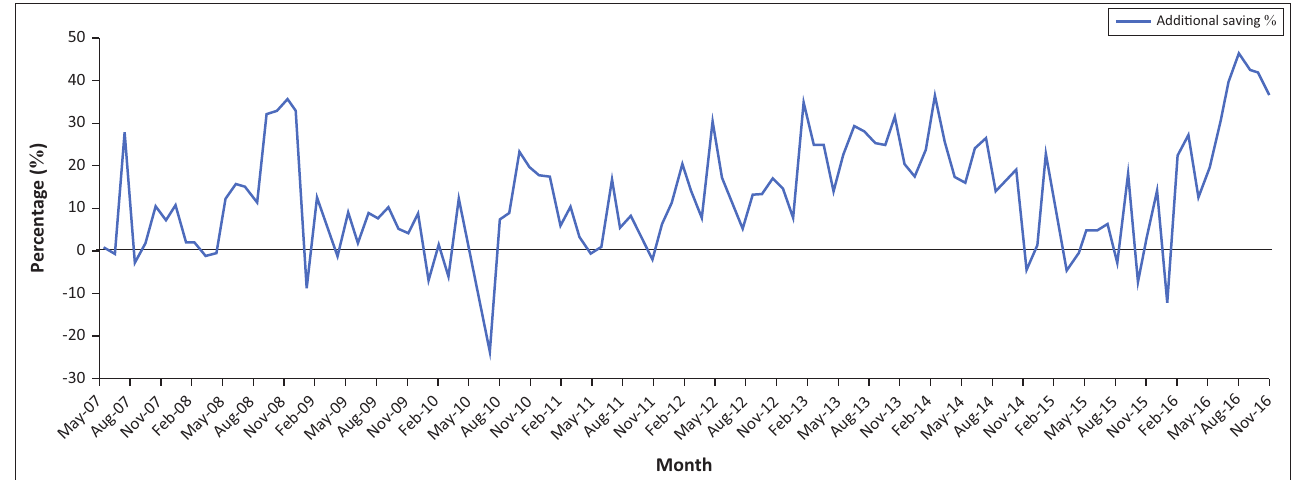
FIGURE 9: Revised benchmark index compared to consolidated actual index.